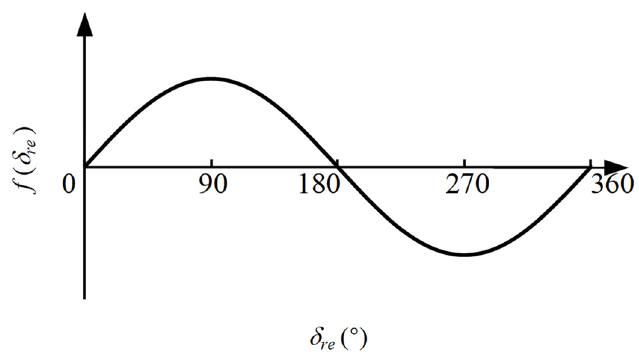
Figure 6. Error function of the rotor windings position.